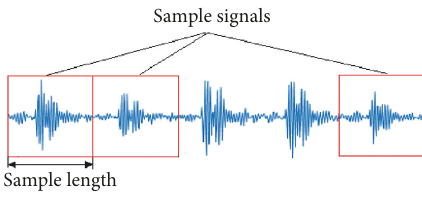
Figure 6: Data sampling in CWRU. Table 1: Dataset description in CWRU.